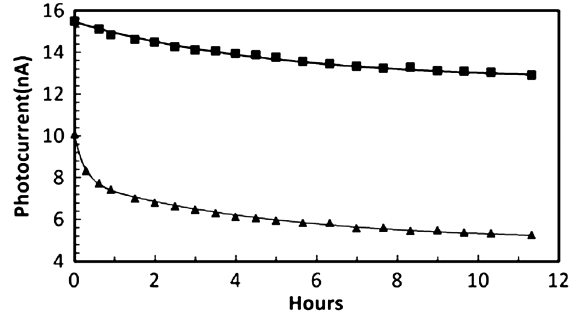
FIG. 2. The stabilization of the photocurrent of hydrogenated diamonds in 11 hours. The solid square is the photocurrent of the high-temperature-treated diamond; the solid triangle is the pho- tocurrent of hydrogenation decay at room temperature. The thin black curves are the best fit